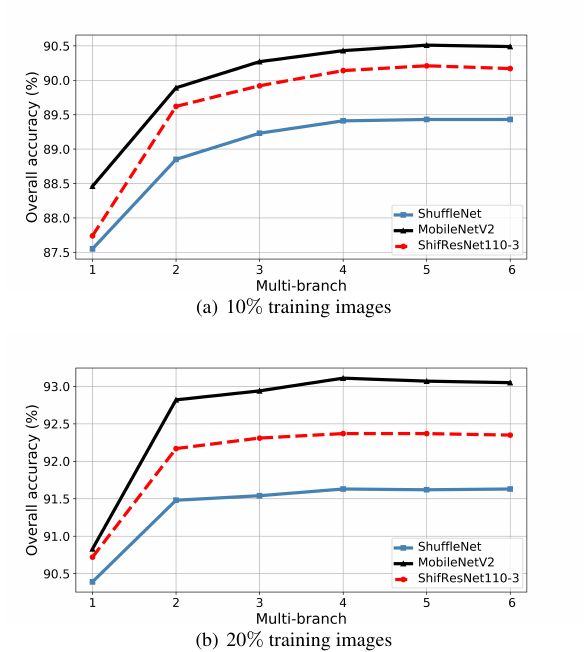
Figure 5. Performance of DMP-CNNs with different branch numbers on the NWPU-RESISC45 data set.